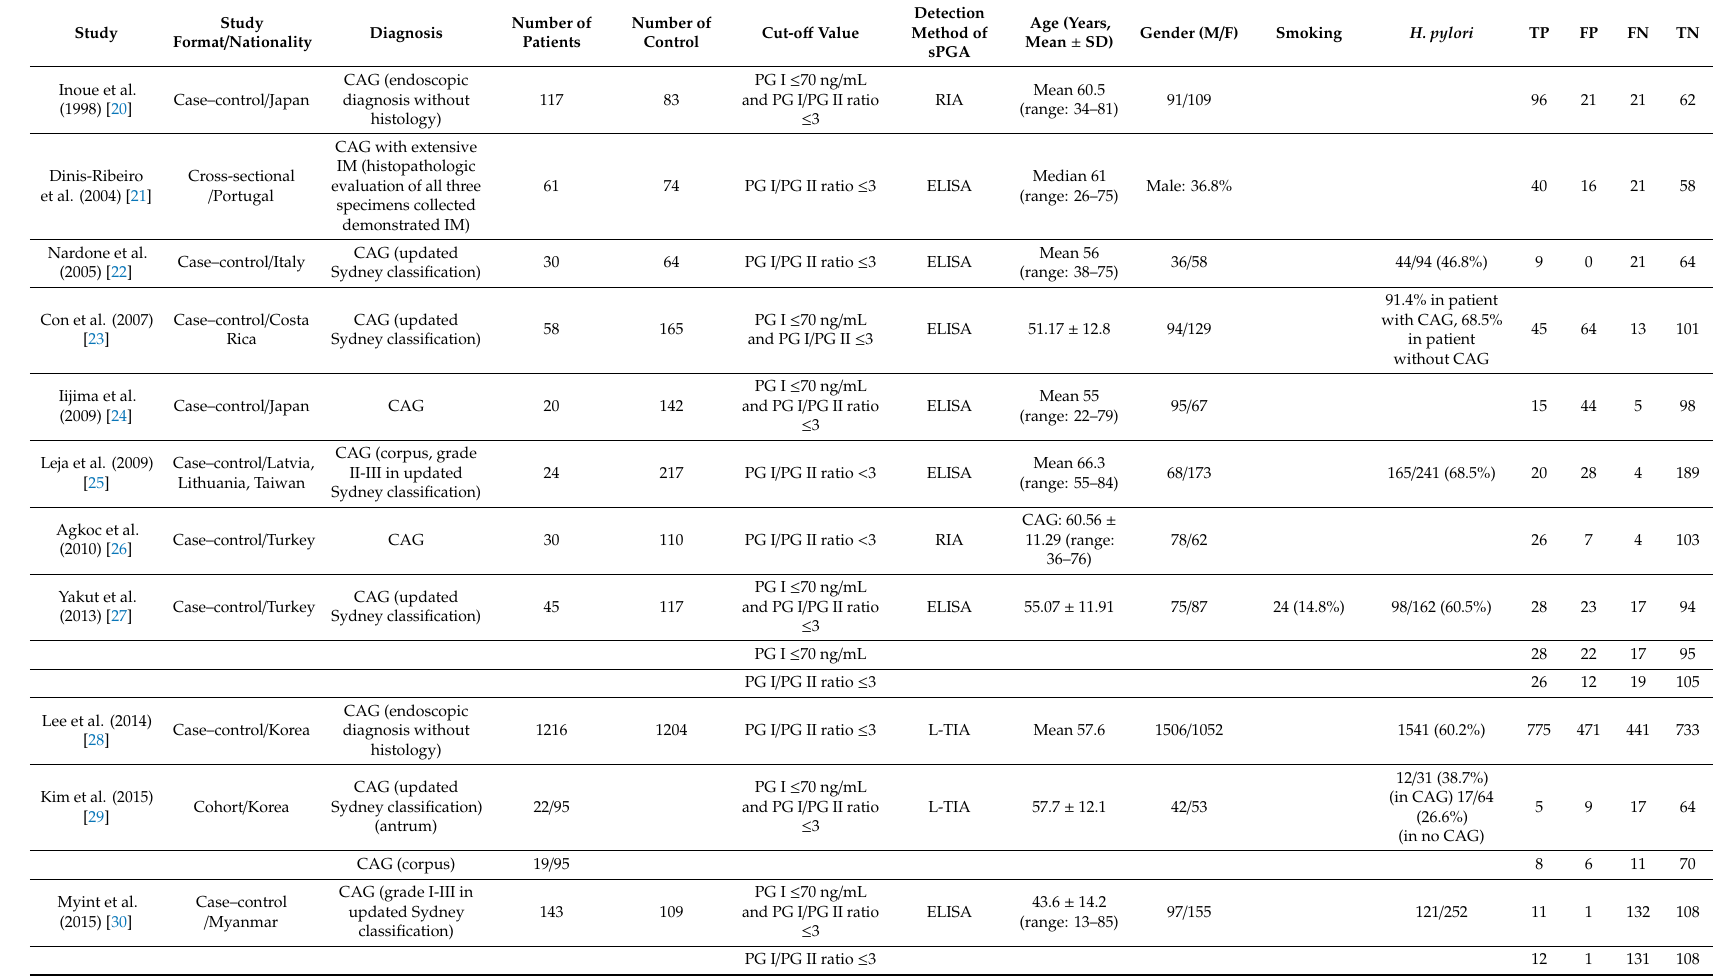
Table 3. Clinical characteristics of the included studies for the diagnosis of